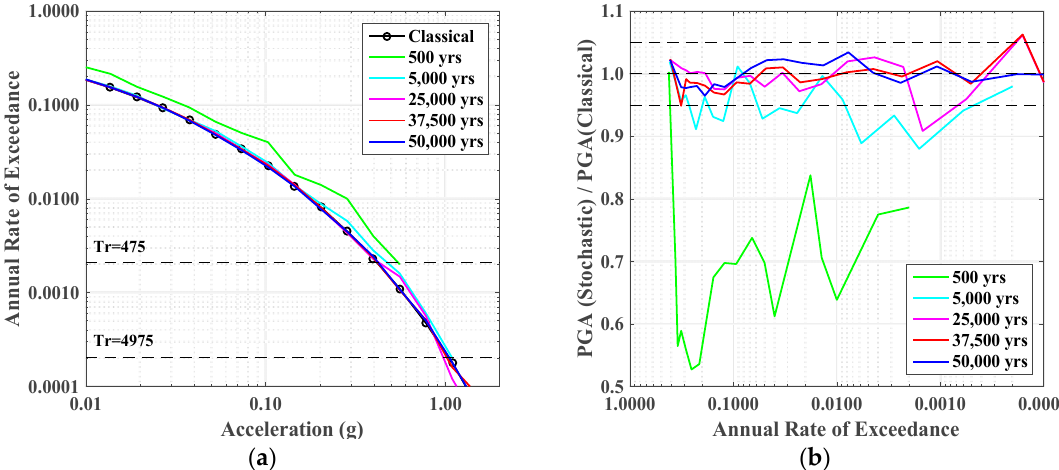
Figure 6. ( a ) Hazard curves built from five earthquake catalogs with increasing lengths (from 500 to 50,000 years). ( b ) Ratio between the acceleration obtained from the Monte Carlo method and the expected acceleration, interpolated for given annual rates.